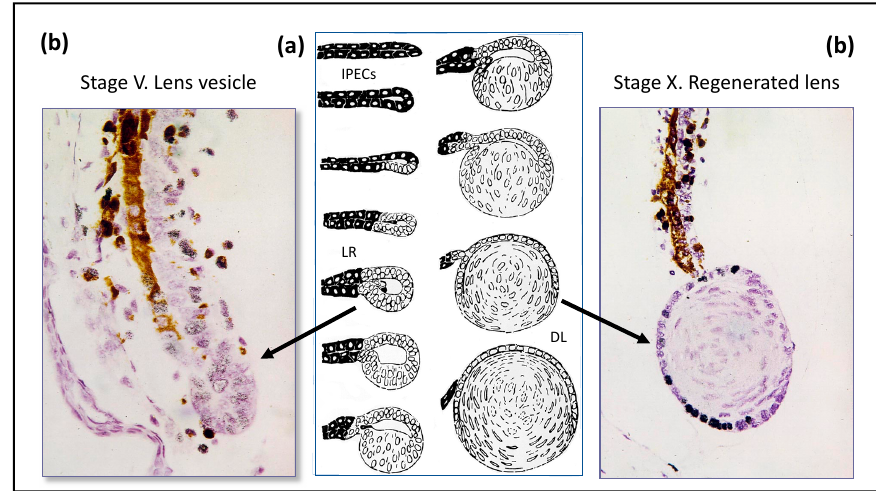
Figure 3. ( a ) Stages of regeneration of eye lens from the dorsal part of the iris after lens surgical extirpation in the newt. IPECs—iris pigment epithelial cells, LR—lens regenerate, DL—differentiated lens. ( b ) Histological pictures of newly forming lens (grey and black nuclei—inclusion of 3 H- thymidine labelled cells).